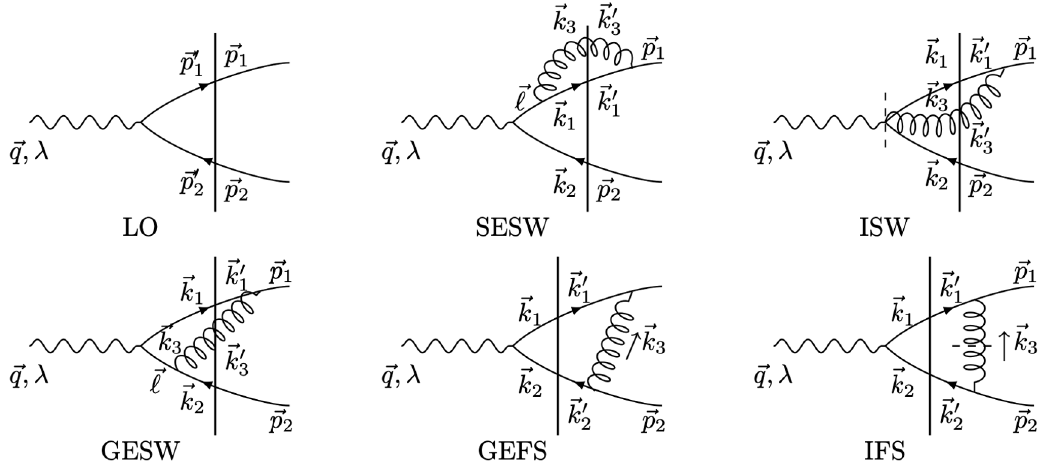
Figure 1 . LO : the leading-order Feynman diagram. The shockwave of semiclassical gluon fields from the hadron target is depicted by the full vertical line. SESW : self-energy correction traversing the